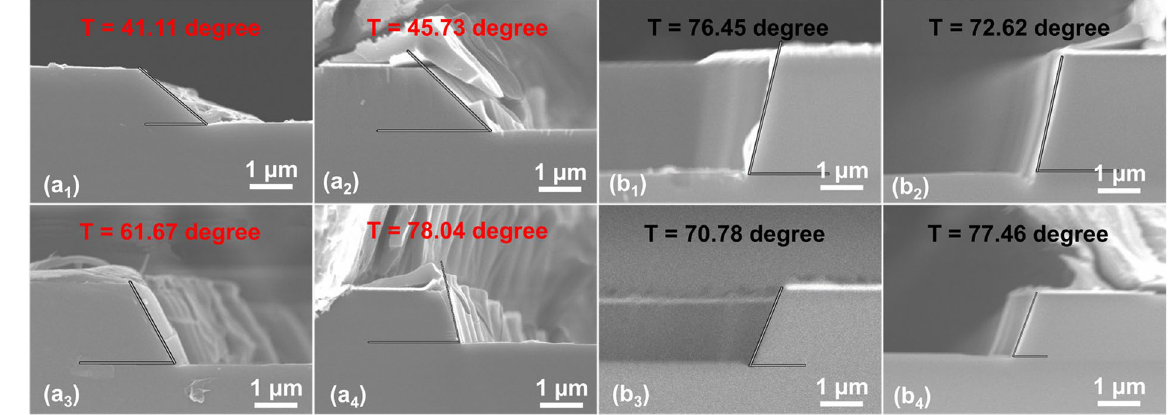
Figure 4. SEM images of the etching profile angles obtained with different mixture ratios of BCl 3 with (BCl 3 + N 2 ) labelled as ( a ) and (BCl 3 + Cl 2 ) labelled as ( b ), showing that etching angles can be controlled by adjusting the gas mixture ratio. (a 1 ) Mixture ratio of 20% results in the lowest etching angle, 41.11°; (a 2 ) mixture ratio of 40% results in an etching angle of 45.73°; (a 3 ) mixture ratio of 80% results in an etching angle of 61.67°; and (a 4 ) BCl 3 gas alone (100%) results in the largest etching angle of 78.04°. (b 1 ) Mixture ratio of 20% results in an etching angle of 76.45°; (b 2 ) mixture ratio of 40% results in an etching angle of 72.62°; (b 3 ) mixture ratio of 80% results in the lowest etching angle of 70.78°; and (b 4 ) BCl 3 gas alone (100%) results in the largest etching angle of